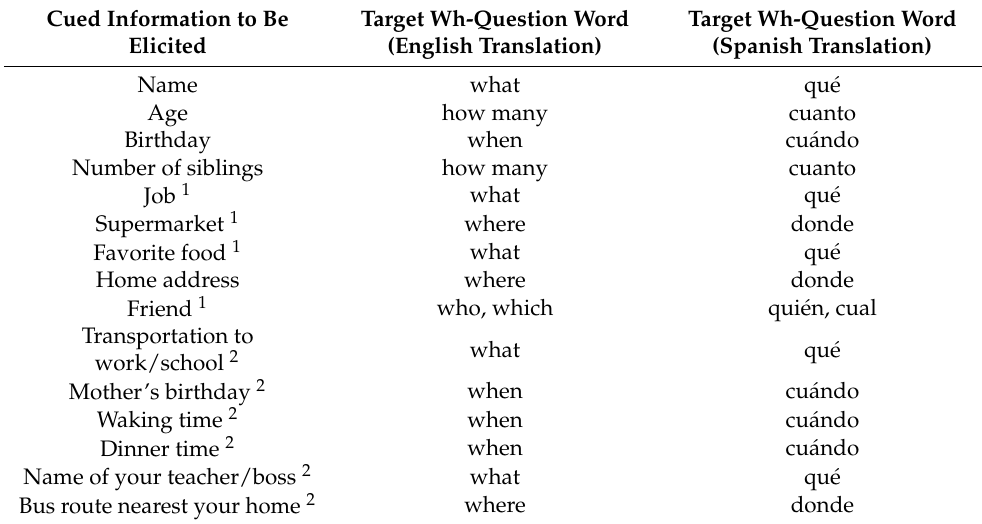
Table 1. Items of information that participants were asked to elicit from the confederate, and their respective targeted wh-question